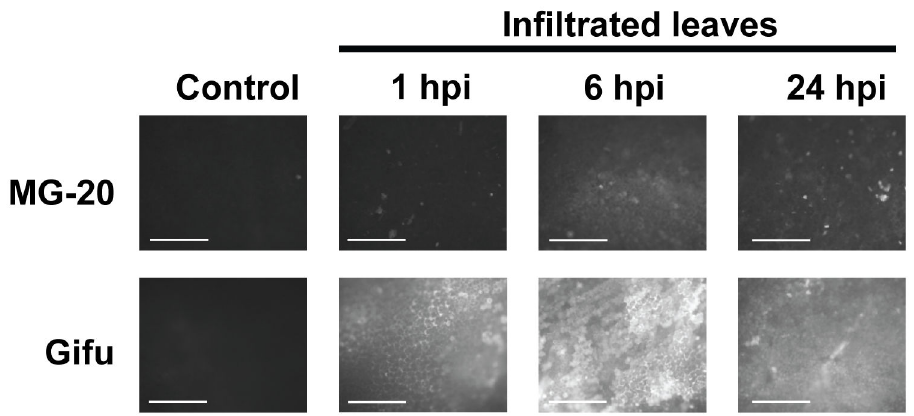
Figure 2. Effect of bacterial infiltration on ROS accumulation in L. japonicus leaves. Detached leaves of each ecotype were submerged for 30 min in a solution of 15 µM DCFDA and infiltrated with a bacterial solution or MgCl incubated in freshly prepared DCFDA solution and observed under fluorescence microscopy at indicated time points (excitation filter, 460 nm; emission filter, >515 nm). Figure shows representative photographs of control and treated leaves. Bars: 500 µm.